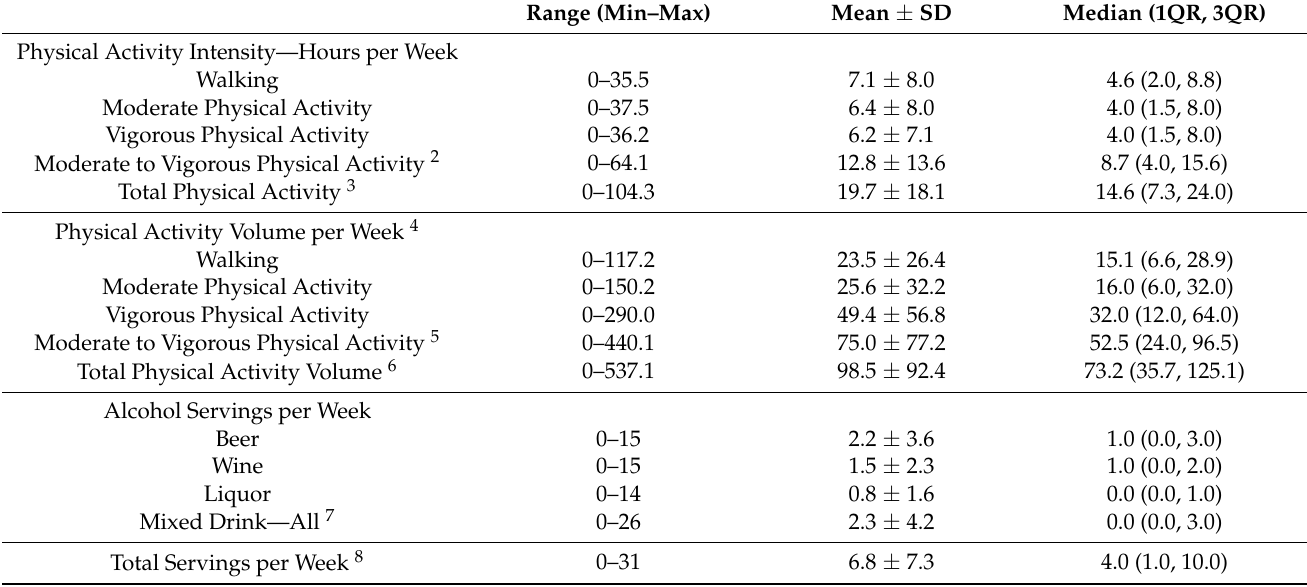
Table 2. Physical activity and alcohol use behaviors 1 .